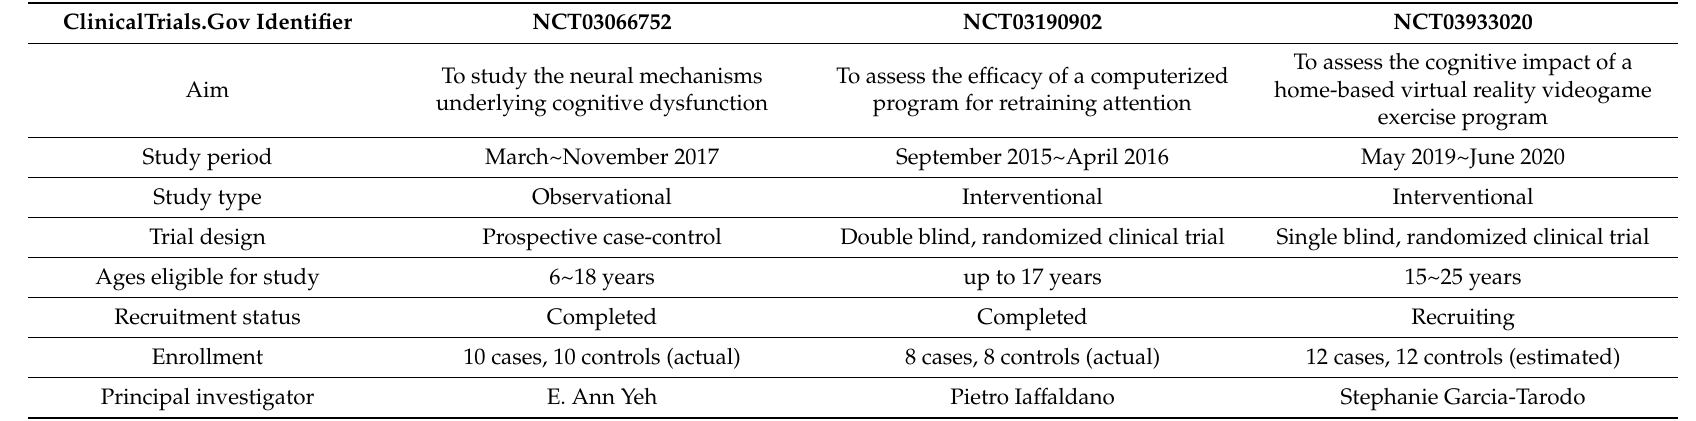
Table 4. Registered clinical trials primarily focusing on cognitive issues in